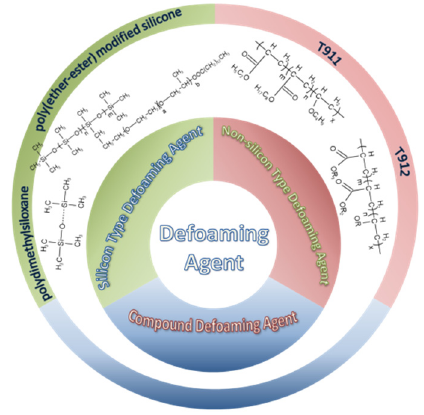
Figure 4. The main types of defoaming agents.